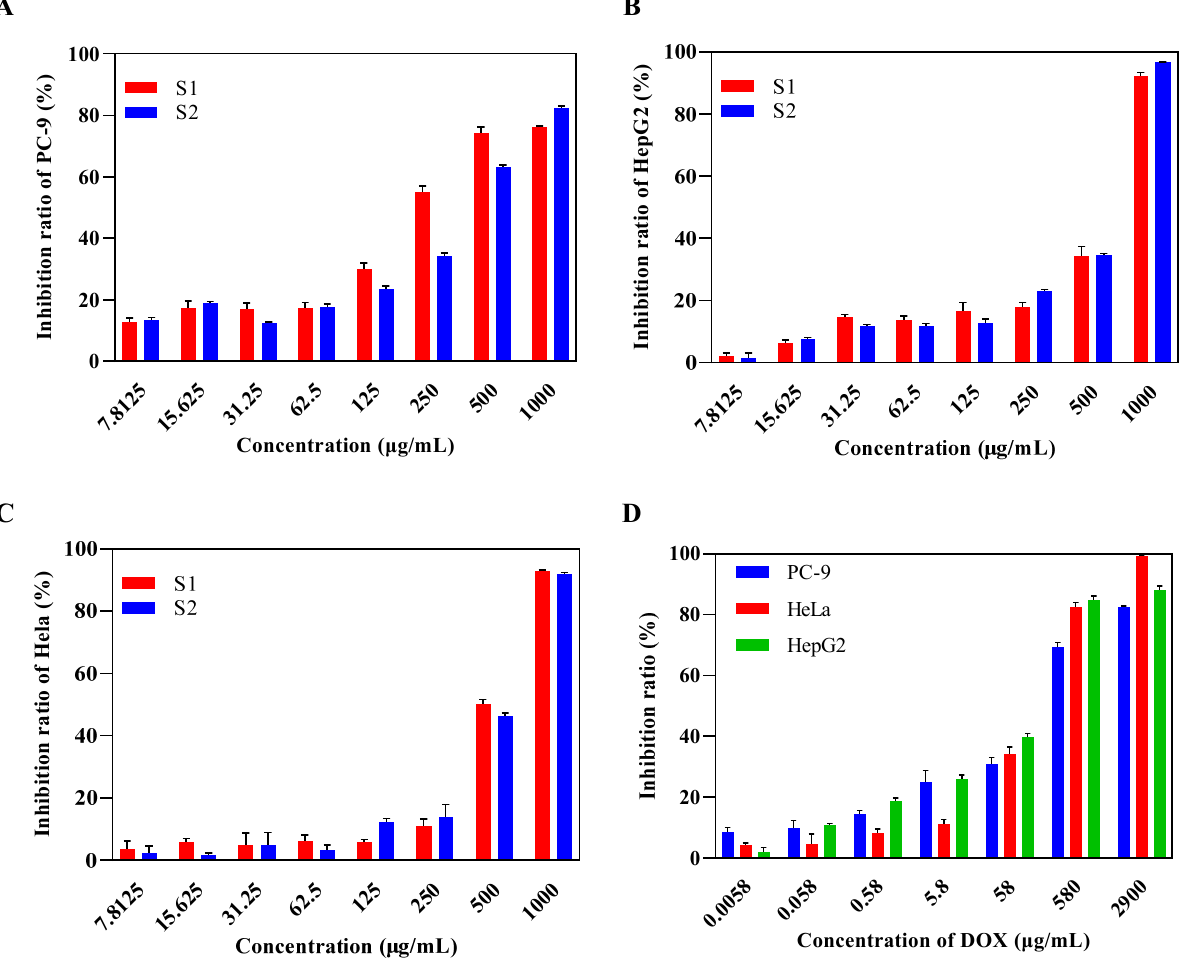
Figure 9. Effects of S1 and S2 on the inhibition ratios of cancer cells PC-9 ( A ), Hela ( B ), and HepG2 ( C ) in vitro, with DOX as a positive control ( D ).